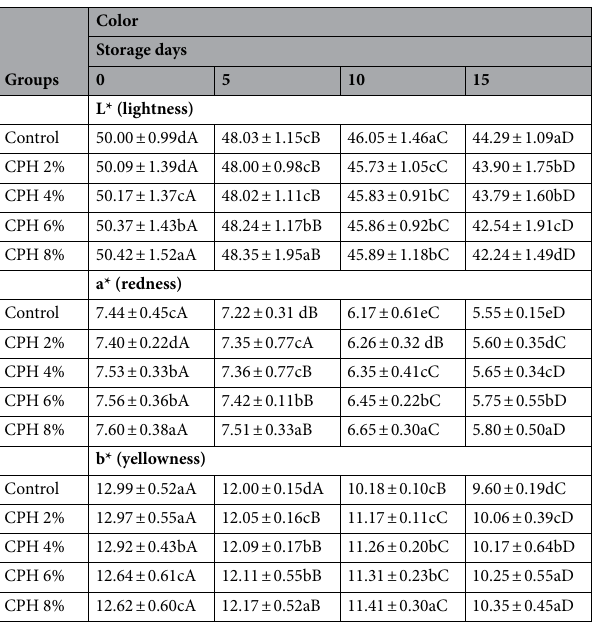
Table 7. Color of casein protein hydrolysate (CPH) powder incorporated raw beef nuggets. CPH: casein protein hydrolysate. All the values are means of triplicate determinations ± Standard Deviation (SD). Means within the column with different small letters are significantly different (p < 0.05) and different capital letters within the row differed significantly.